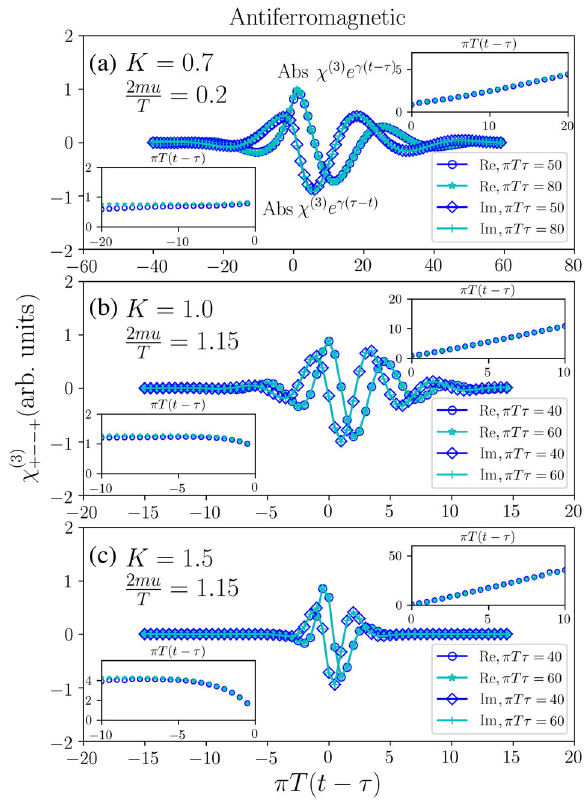
ð 3 Þ þ −− þ of an ¼ 1 . w